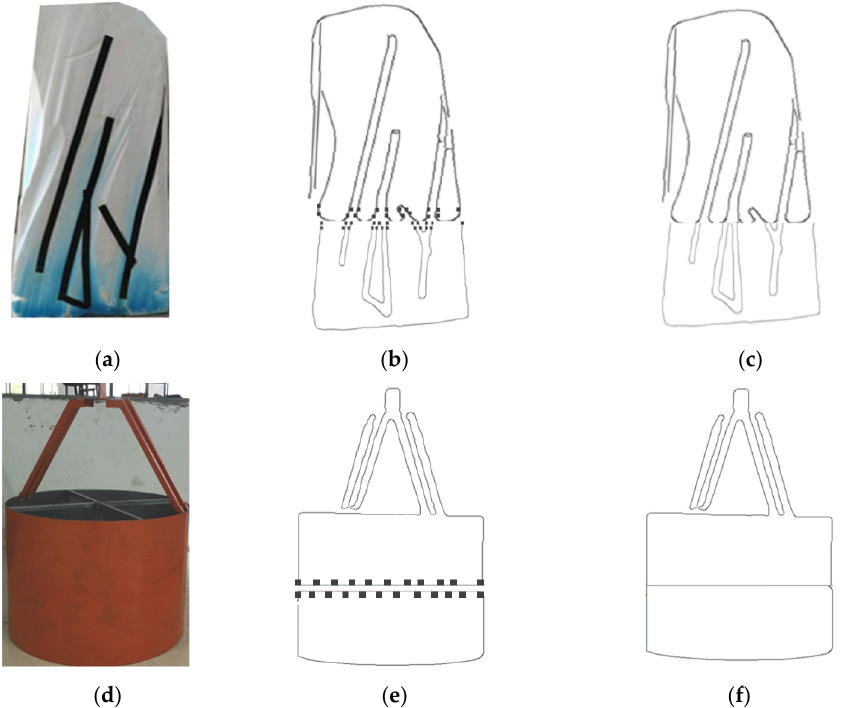
Figure 21. Comparison of stitching results of the obstacles. ( a ) Physical picture of the obstacle 1. ( b ) Encoding points selection of the obstacle 1. ( c ) Stitching result of the obstacle 1. ( d ) Physical picture of the obstacle 2. ( e ) Encoding points selection of the obstacle 2. ( f ) Stitching result of the obstacle 2.